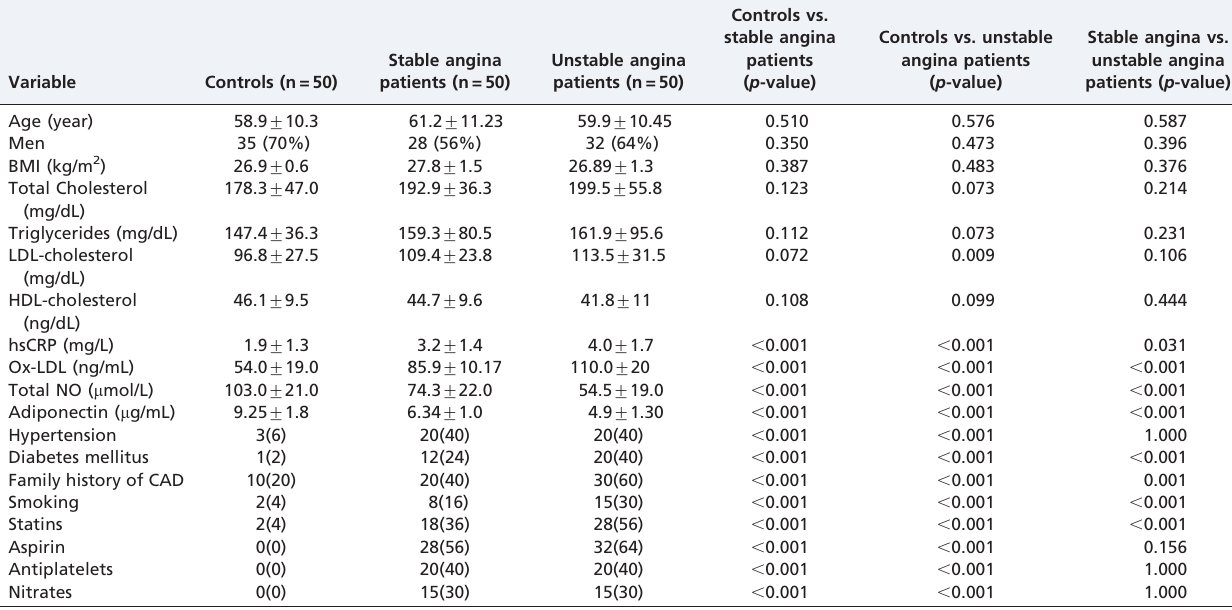
Stable angina vs. unstable angina